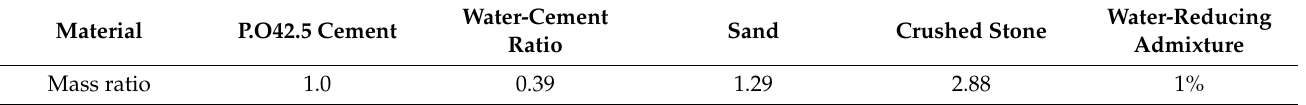
Table 2. The mix design of the C30